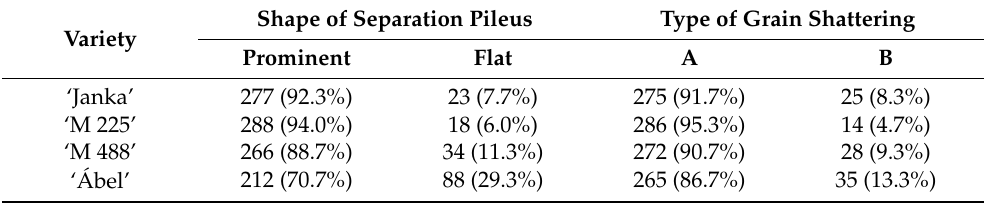
Table 2. The shape of separation pileus and the type of grain shattering of four rice varieties. Type A: separated between sterile lemma and rudimentary glume. Type B: torn off at bent portion of the pedicel.